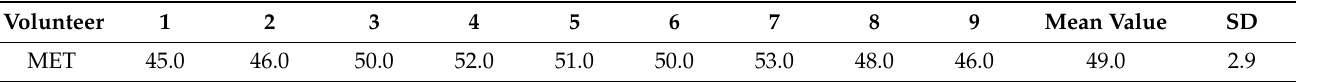
Table 2. Maximum endurance times (METs) of each volunteer under 60% MVC SC exercise (/s).